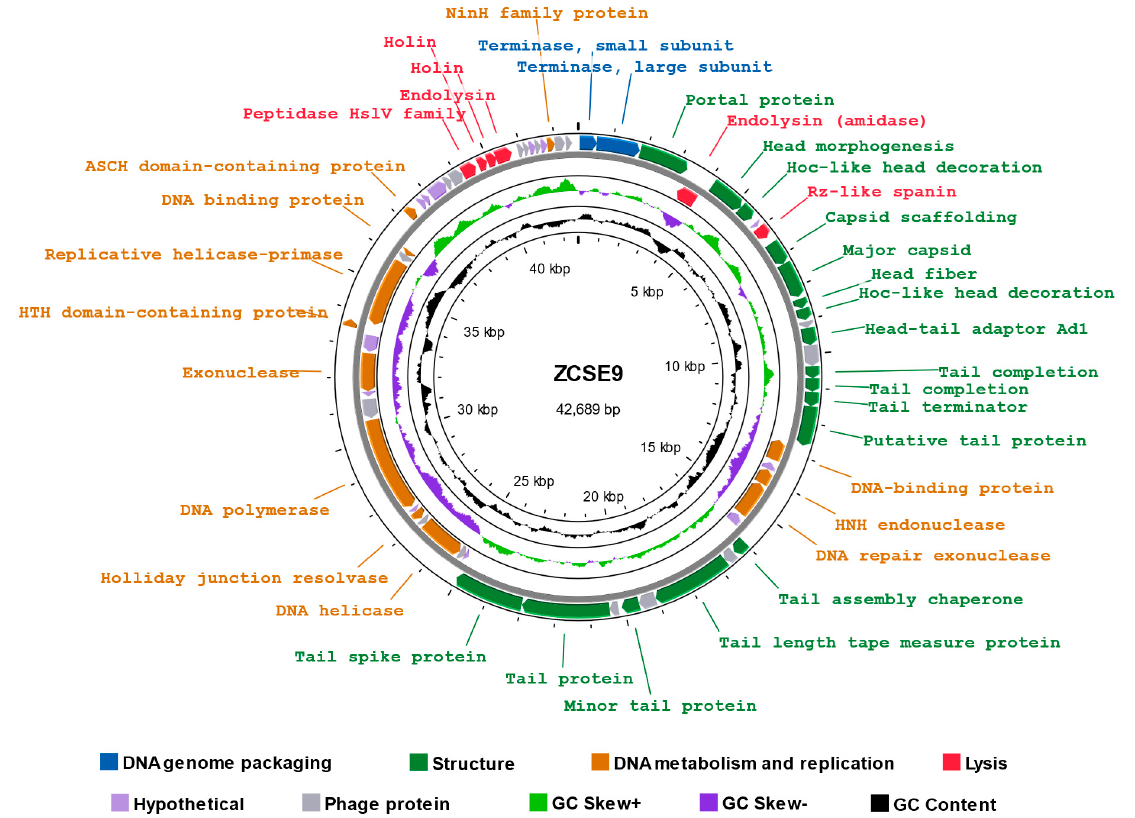
Figure 5. Genomic map of ZCSE9, created with PROKSEE software. The color coding represents the coding sequences (CDS) according to different categories of the predicted function: DNA genome packaging (blue); structure (green); DNA metabolism and replication (orange); lysis (red); phage and hypothetical proteins (shades of grey); GC content skew (black); GC skew (green and purple).